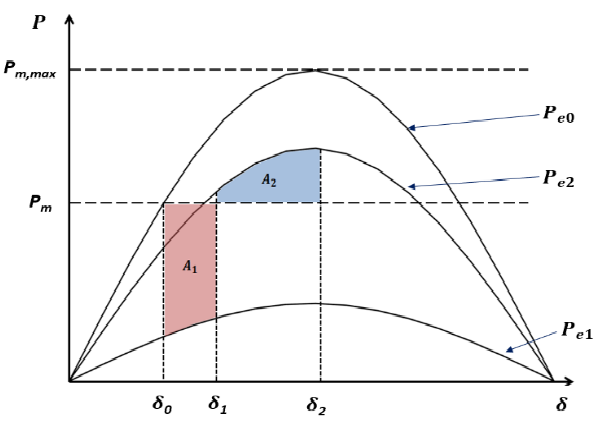
Figure 1. Illustration of equal area criterion (EAC) .